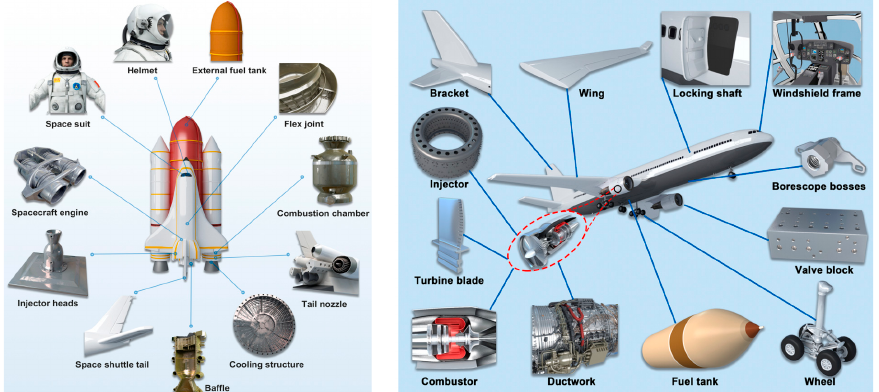
Figure 14. Applications of AM in the field of aerospace: astronautics ( left ), aeronautics ( right ). Figure reproduced from [9]. SpaceX’s manned Dragon spacecraft carried two astronauts, Bob Behnken and Doug Hurley, who donned 3D printed helmets for the space voyage (Figure 15). Along with the production of the Dragon V2 and Falcon 9 rockets, SpaceX also uses 3D printing for this